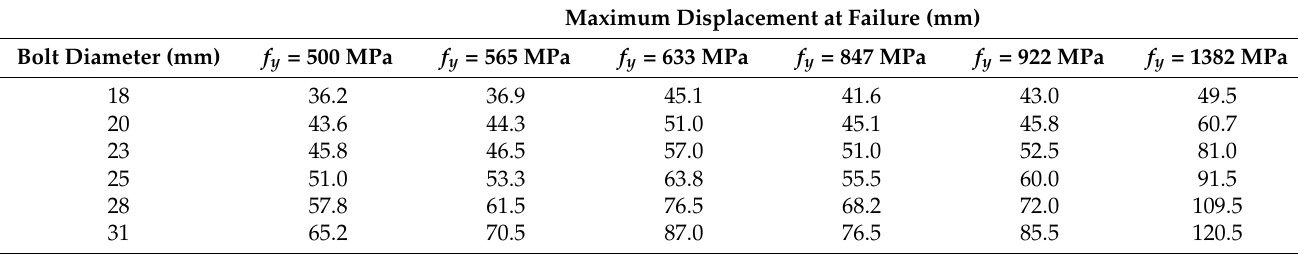
Table 15. Maximum displacement of failure of statically loaded